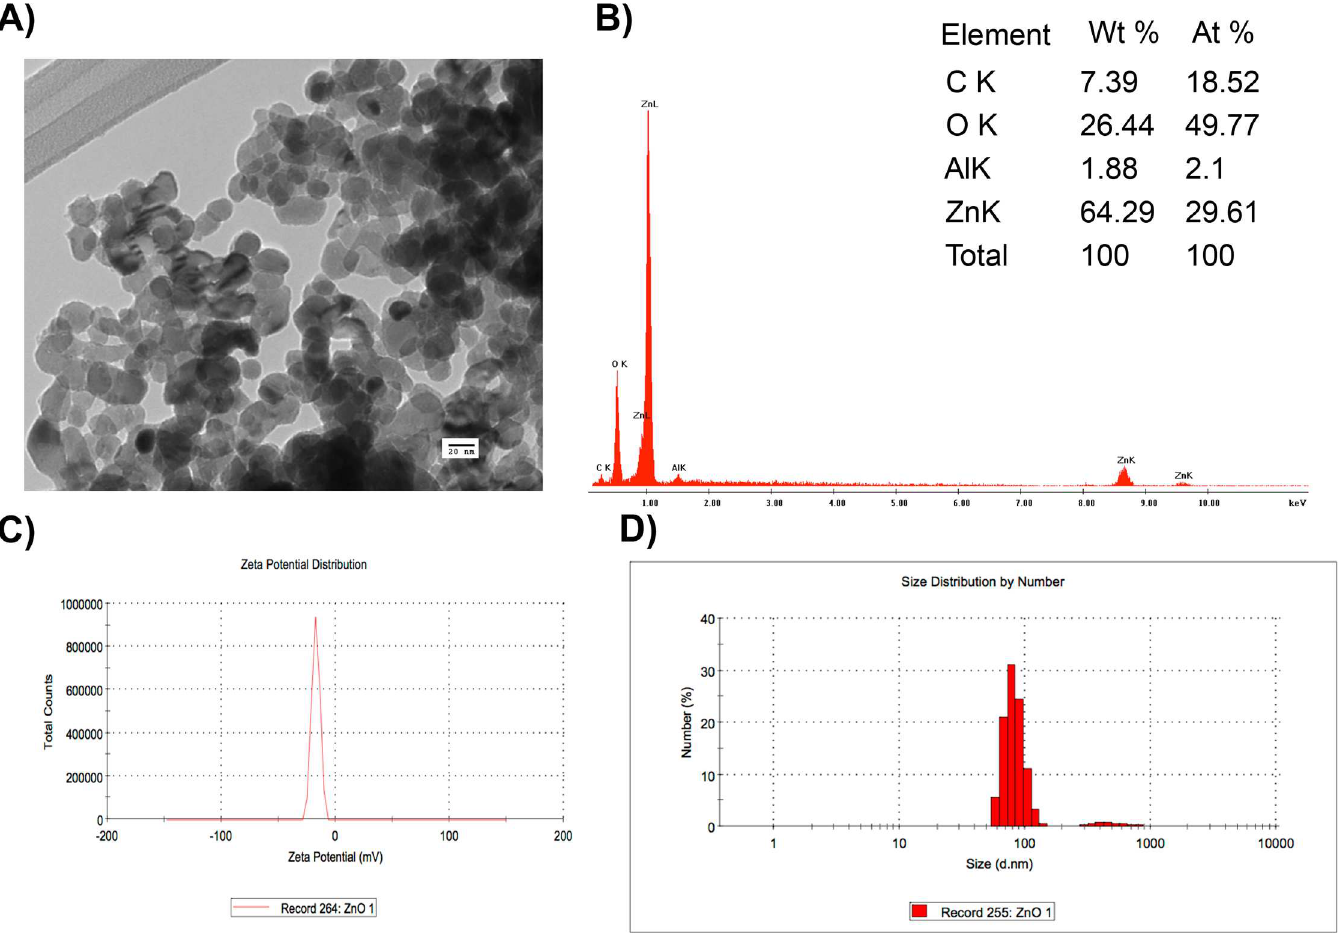
Fig 2. Characterizationof ZnO-NPs using (A) TEM, (B) elementanalysisby SEM, (C) zeta potential, and (D) size distribution.